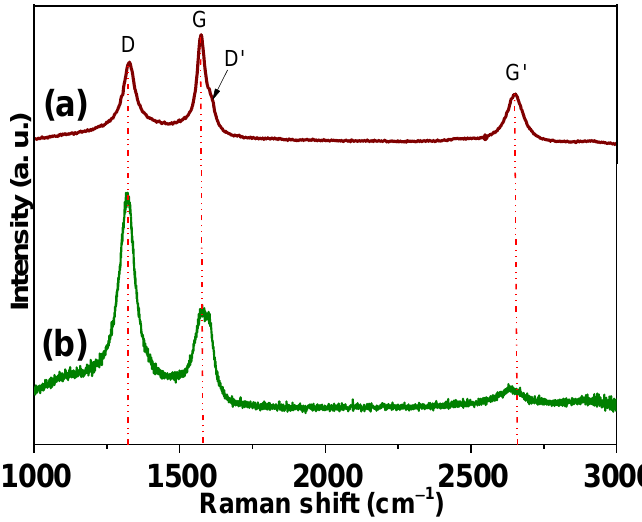
Figure 4. Raman spectra acquired of ( a ) Selected MWCNTs synthesized at W 0.1 F 50 t 60 T 1123 followed with an acid purification (HCl + H 2 O 2 ) and ( b ) commercial MWCNTs purified under similar con- ditions.